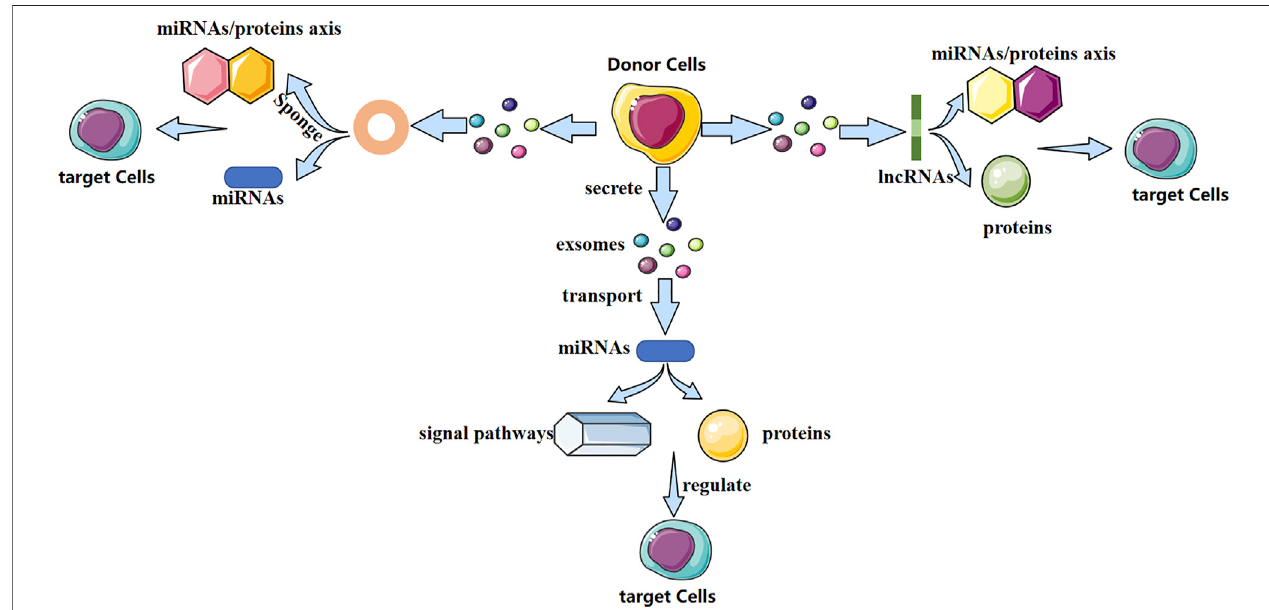
FIGURE1 | Possible mechanism ofaction of three exosomal non-codingRNAs (schematic).Differentexosomal non-coding RNAs (miRNA, lncRNA, and circRNA) regulate the fate and differentiation of target cells through different mechanisms, thereby affecting disease progression.